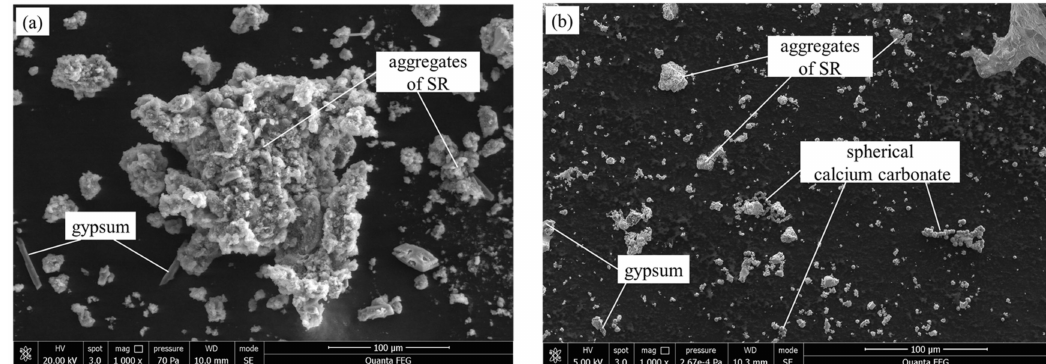
Figure 3. SEM images of SR: ( a ) the raw SR and ( b ) the stirred